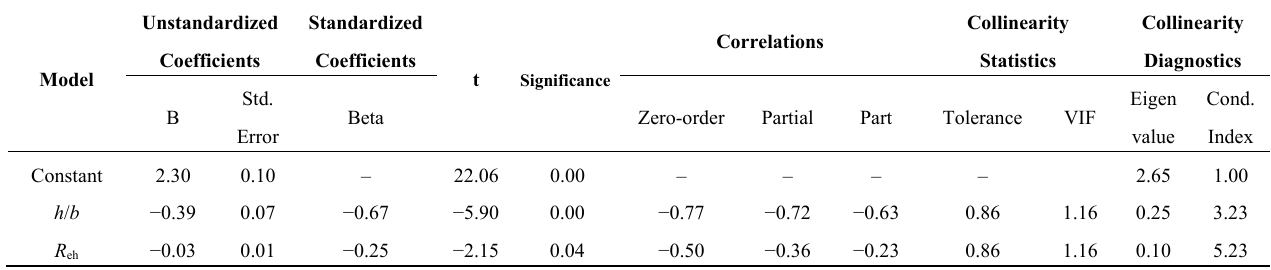
Table 5. Stepwise regression statistics of final (second)